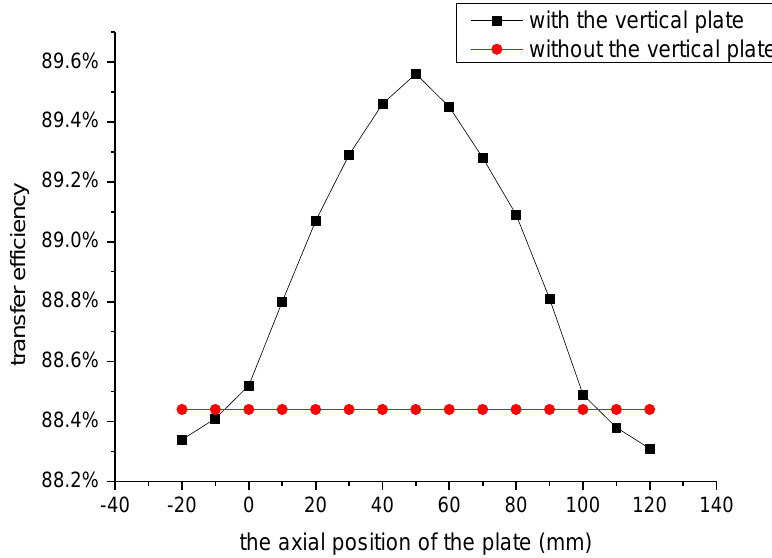
Figure 8. The variation of the system efficiency with the radial distance of the vertical plate.